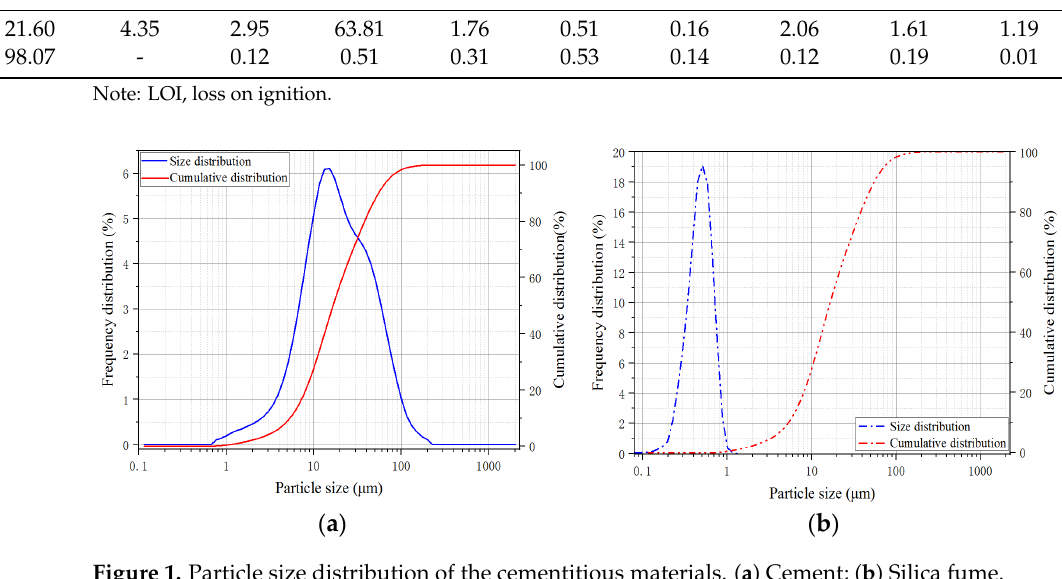
Figure 1. Particle size distribution of the cementitious materials. ( a ) Cement; ( b ) Silica fume. Table 2. Physical properties of the steel